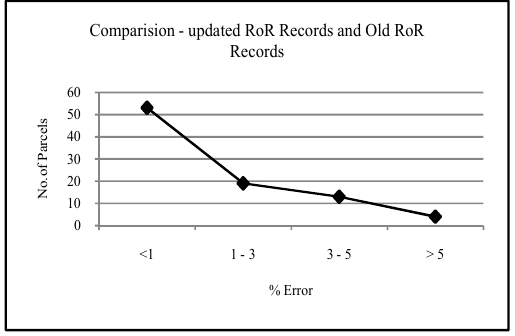
Figure 8. Plot of number of Parcels against the percentage error between old ROR Entry and updated ROR Entry Only 5% parcels have area error more than 5% which indicates deviations over the threshold. This was due the encroachments into natural regions/government lands, etc. (Figure 8) 3.1.4 Area Comparison among ETS-GPS Parcels,